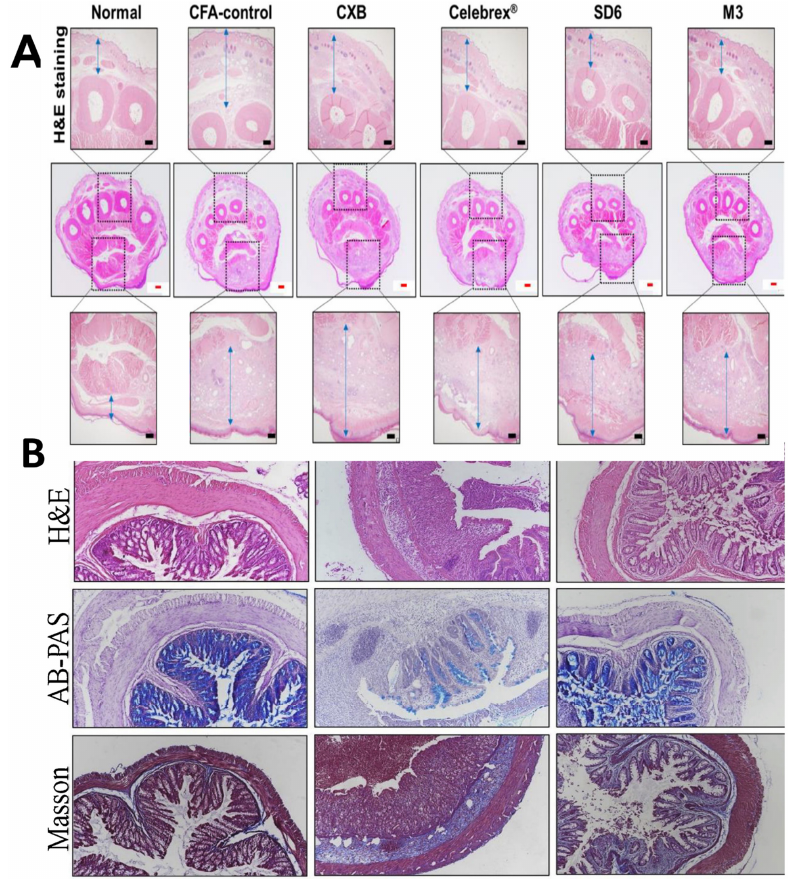
Figure 4. ( A ) Histological micrographs (10× and 40× magnification) of paw tissues of normal, complete Freund’s adjuvant (CFA) control, Celecoxib (CXB), Celebrex ® , previously developed solid dispersion (SD6) and optimal CXB micelles (M3) in CFA-induced rats with H&E staining. Reproduced with permission from [81] © 2020 Elsevier. ( B ) Hematoxylin-Eosin (HE), Alcian Blue Periodic acid Schiff (AB-PAS) and Masson staining results of the colons of colitis mice after treatment with different formulations (20× magnification). Reproduced with permission from [26] © 2020 Elsevier.